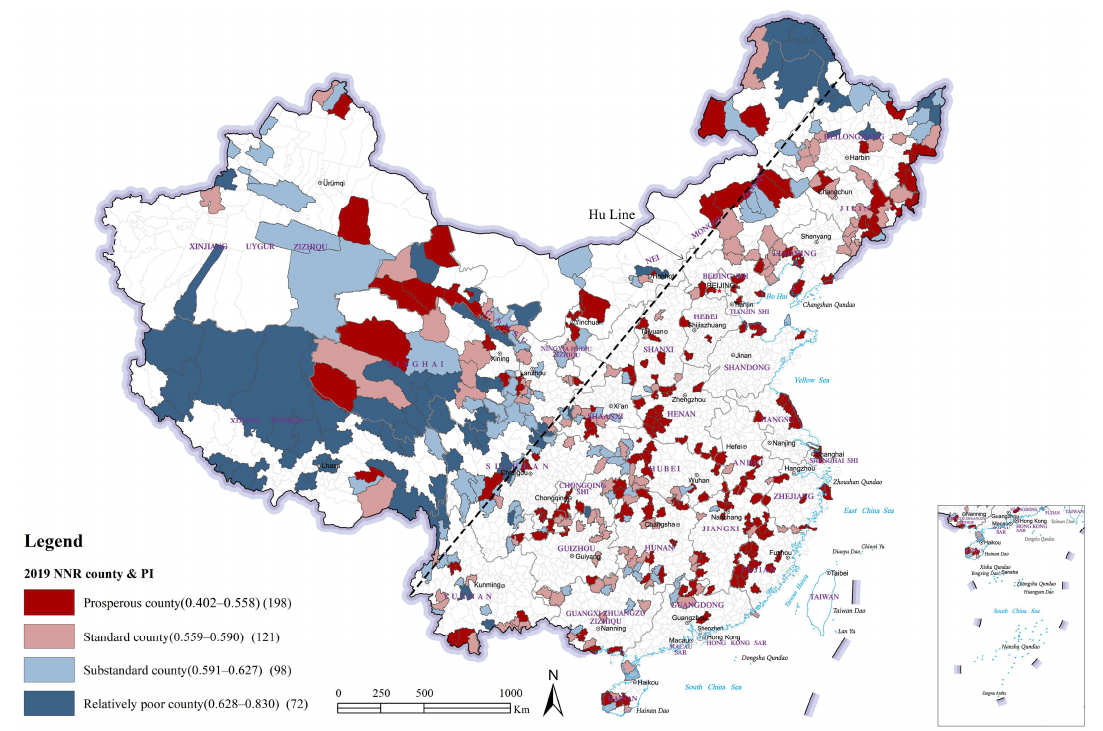
Figure 3. Spatial distribution patterns of four categories of counties affected by PA in 2019.